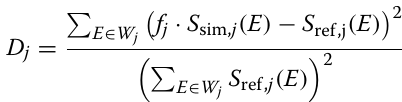
where j denotes one pair of simulated and measured spectra ( S sim, j and S ref, j ). The energy interval W j was set to cover the total range of the radionuclide emissions and the operational range of the detector. The factor f j was introduced as a free parameter for simulations without a collimator (open-field) for which the system response was very sensitive to the exact source-collimator distance used at measurement. For simulations